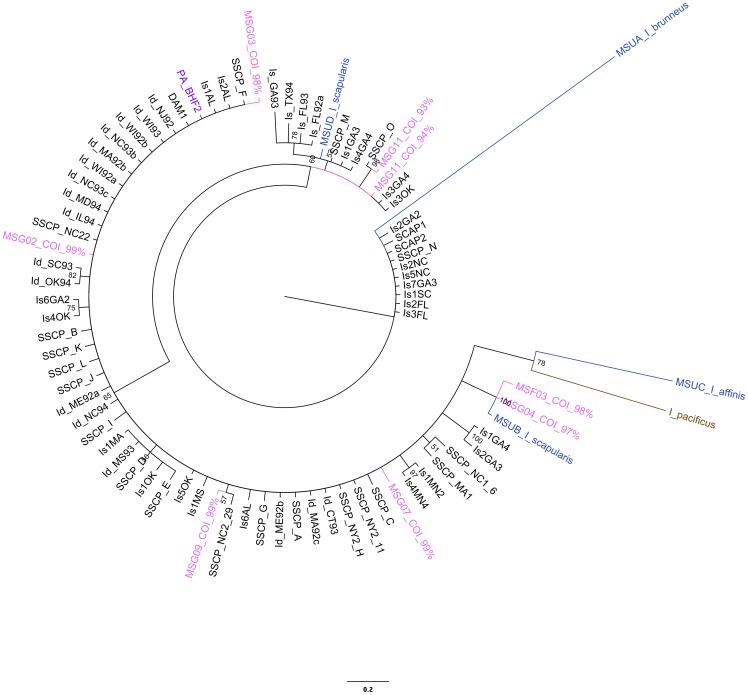

I. scapularis 16S Bayesian phylogeny with placement of MS unknowns.Tree includes all four MS unknowns and was left unrooted. Tree B was rooted to I. pacificus ( = brown) and included only sequences confirmed by blastn to be Ixodes scapularis. Pink = Mississippi samples; purple  =  Pennsylvania; red  =  specimens were blinded until after sequence confirmation. Numbers at nodes represent posterior probability values and branch length corresponds to number of substitutions.